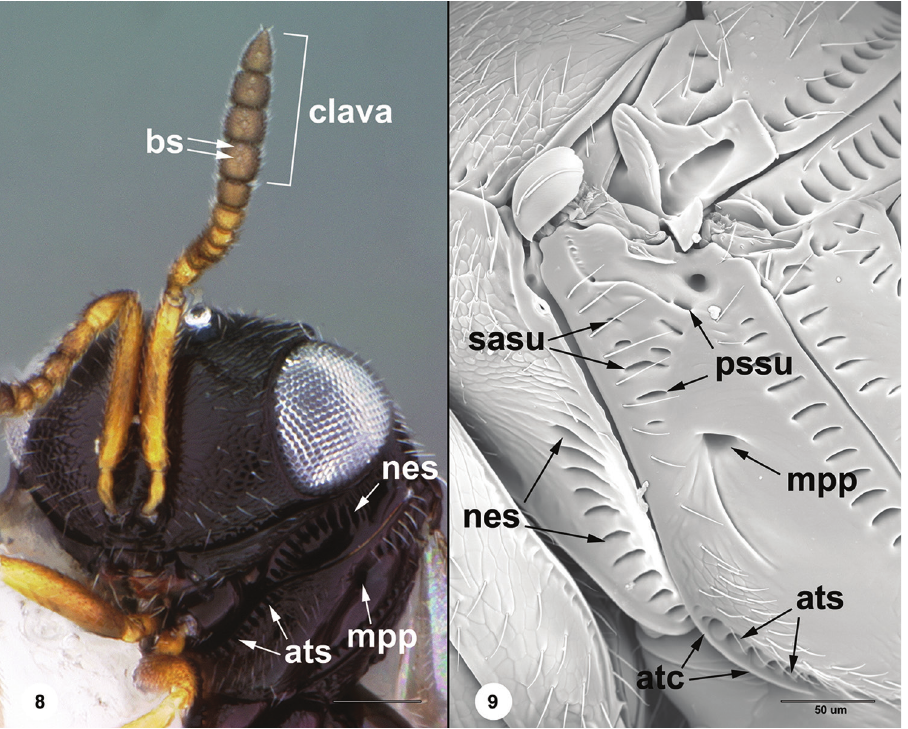
view 9 female (USNMENT01109061), mesosoma, lateral view. atc: acetabular carina; ats: postacetabular sulcus; bs: basiconic sensillum; nes: netrion sulcus; mpp: mesopleural pit; sasu: subacropleural